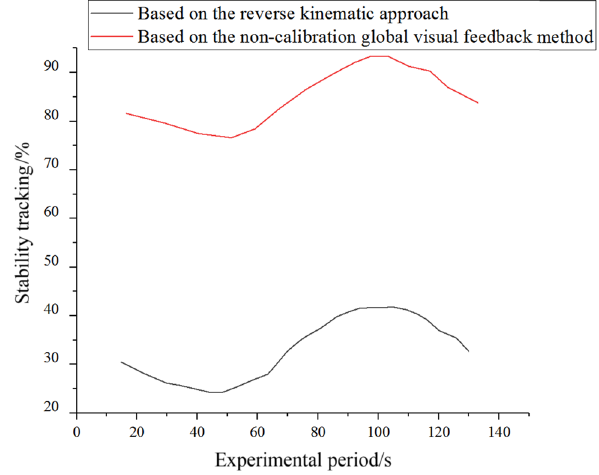
Figure 3: Stability comparison of di ff erent